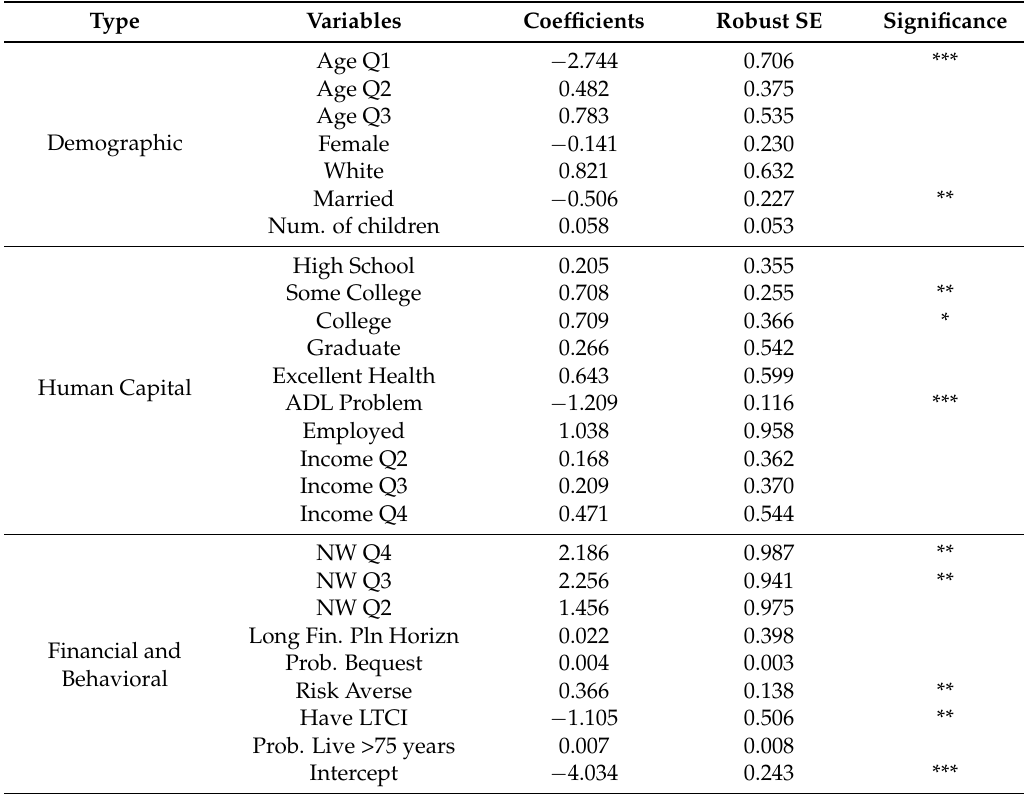
Table 3. Rare event logit for having Reverse Mortgage